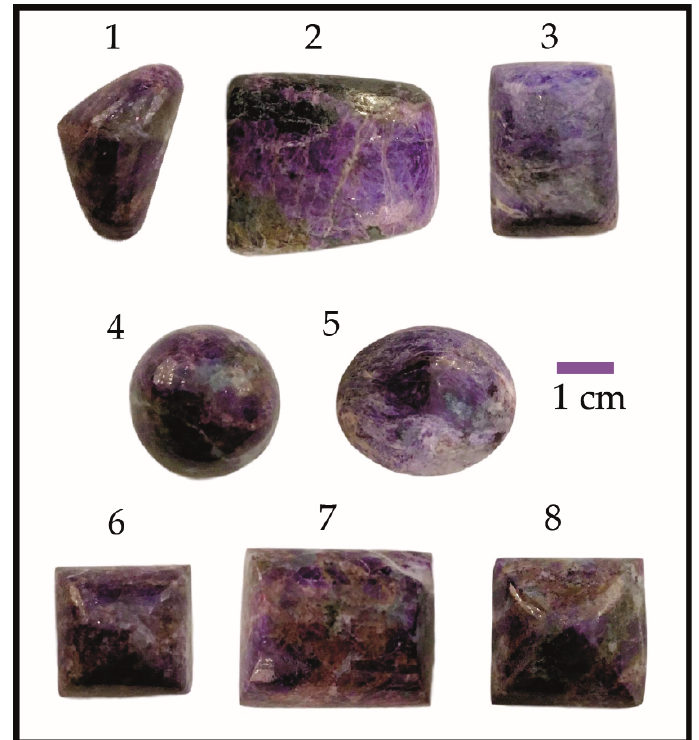
Figure 3. Cut violane stones described in Table 1.